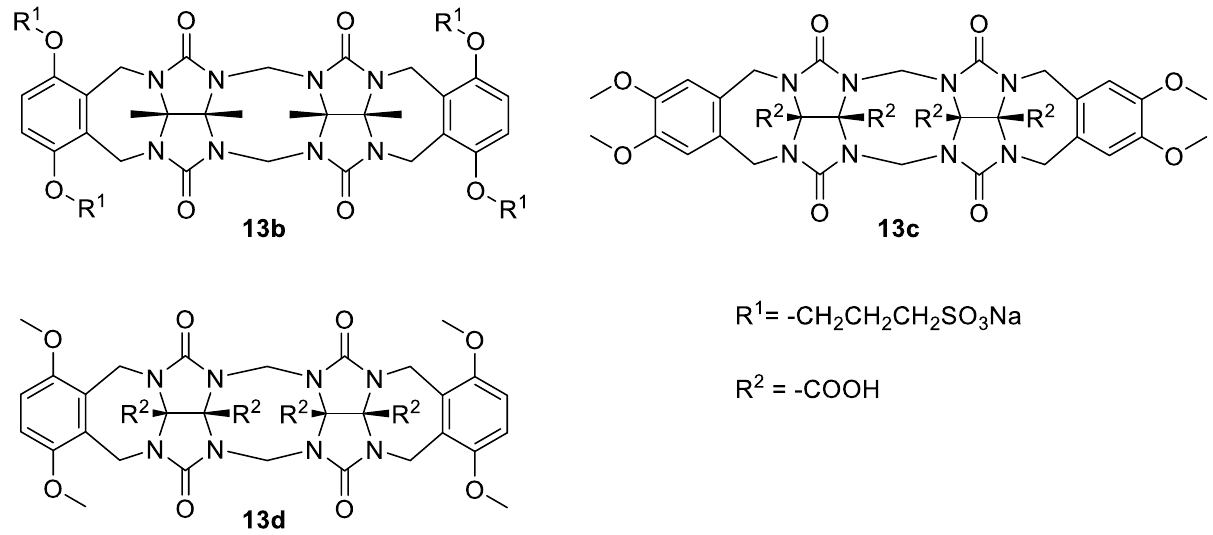
Figure 2. Structures of previously reported glycoluril dimers 13b – d [10,19].